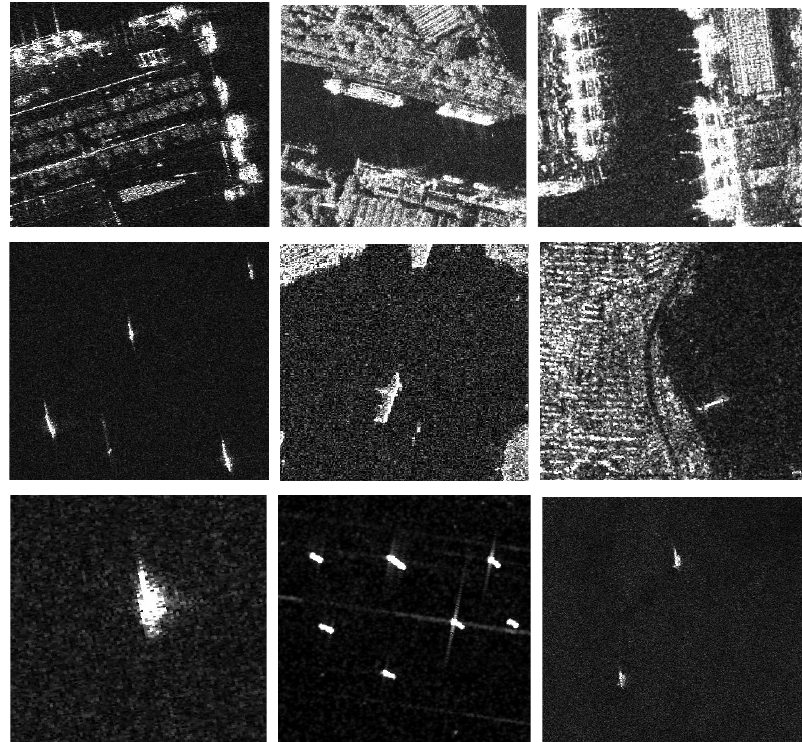
Figure 8. The ship target images in the SSDD dataset. Table 2. Correspondence between NS (number of ships) and NI (number of images) in the SSDD dataset.